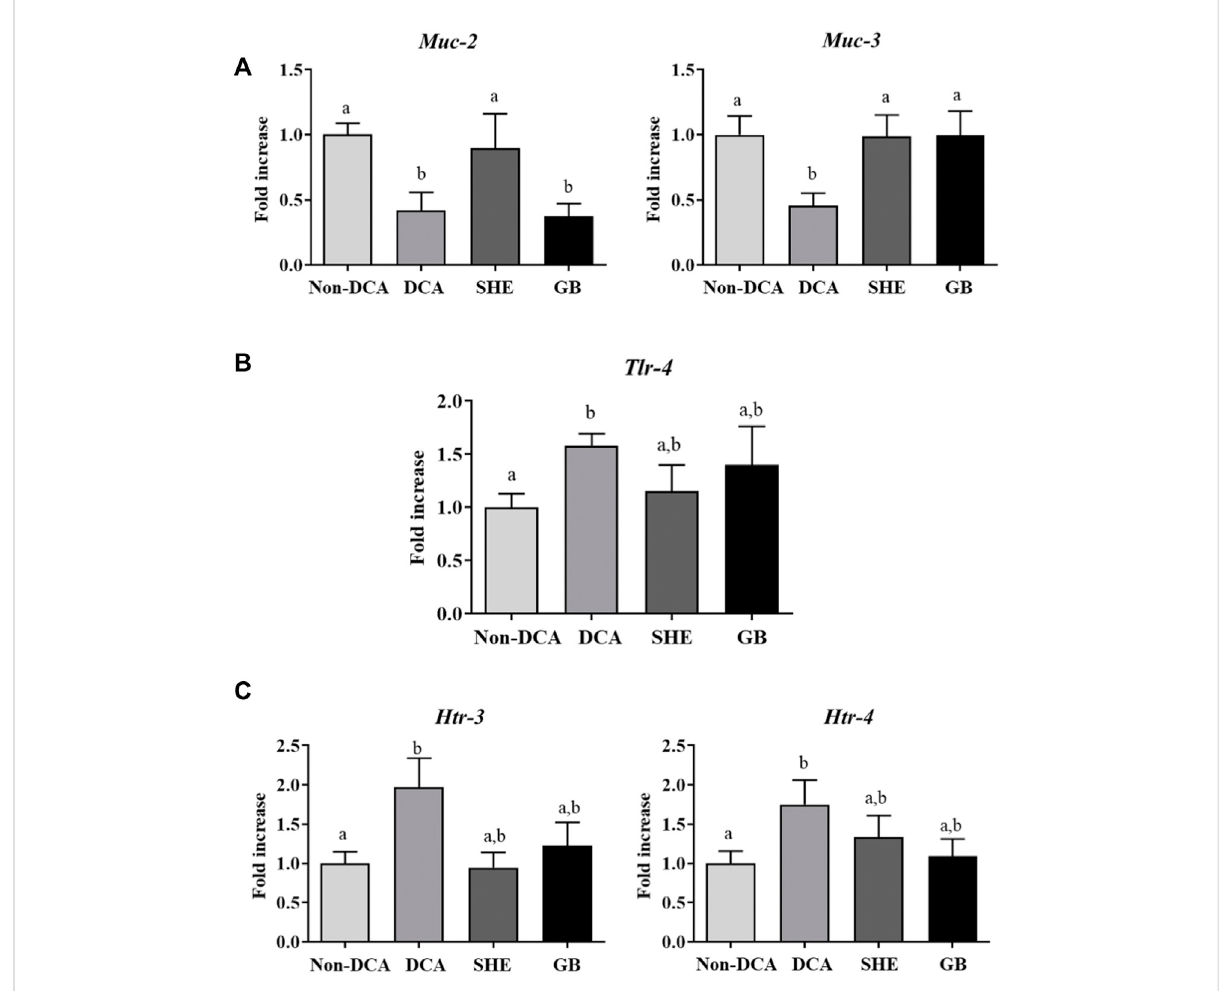
FIGURE 5 Effects of Serpylli herba extract (SHE) (100 mg/kg) or gabapentin (GB) (70 mg/kg) administration on (A) colonic gene expression of Muc-2 and Muc-3 ; (B) colonic gene expression of Tlr-4 and (C) Htr-3 and Htr-4 expression. Data are expressed as means ± SEM ( n = 10). Groups with different letters are statistically different ( p <